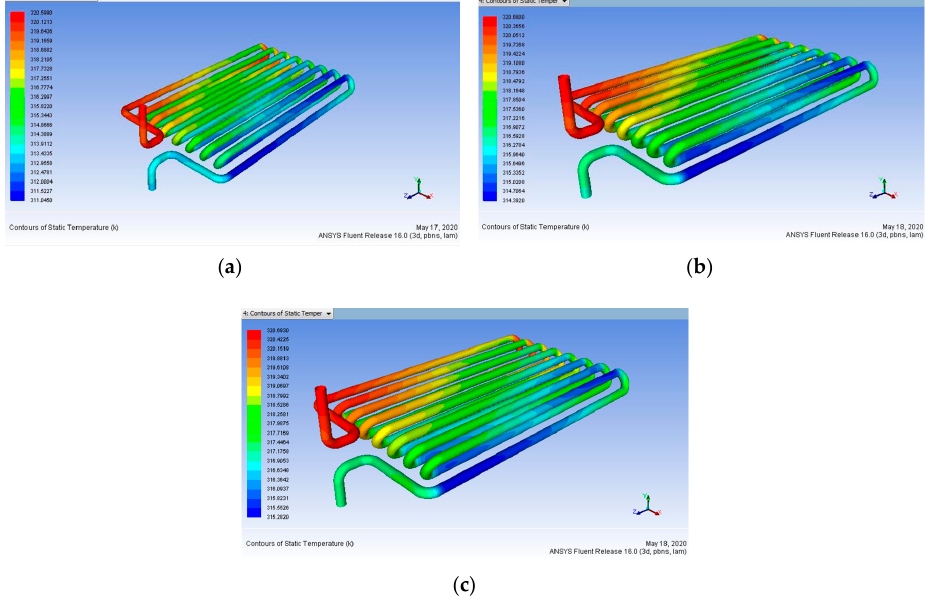
Figure 21. Heat input 363 K vs. mass flow rate ( a ) 0.15, ( b ) 0.30, ( c ) 0.45 L/min (Before Coating).